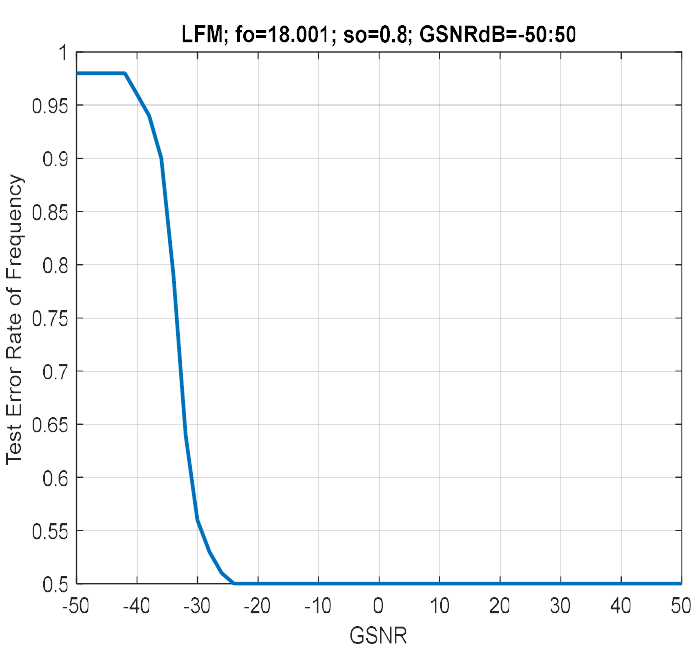
Figure 24. Test error rate for SE of noisy LFM by CNN, where f o =